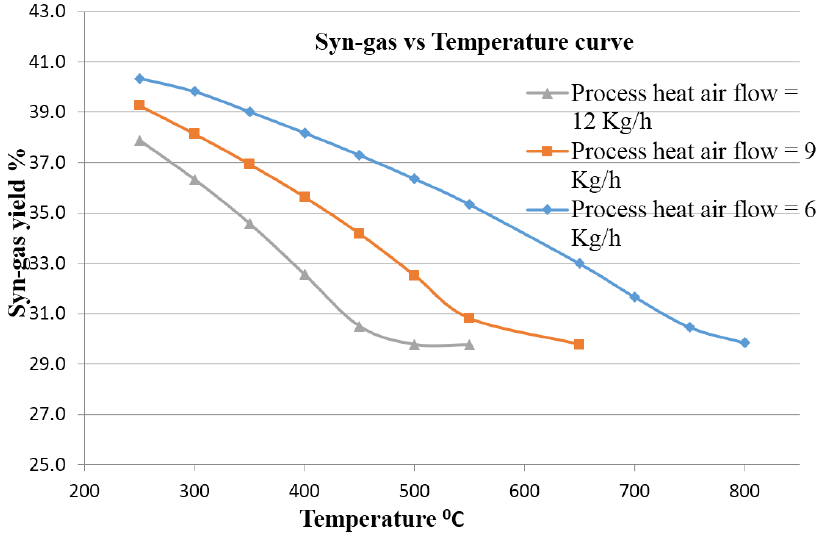
Figure 7. Effect of process heat air flow effect on